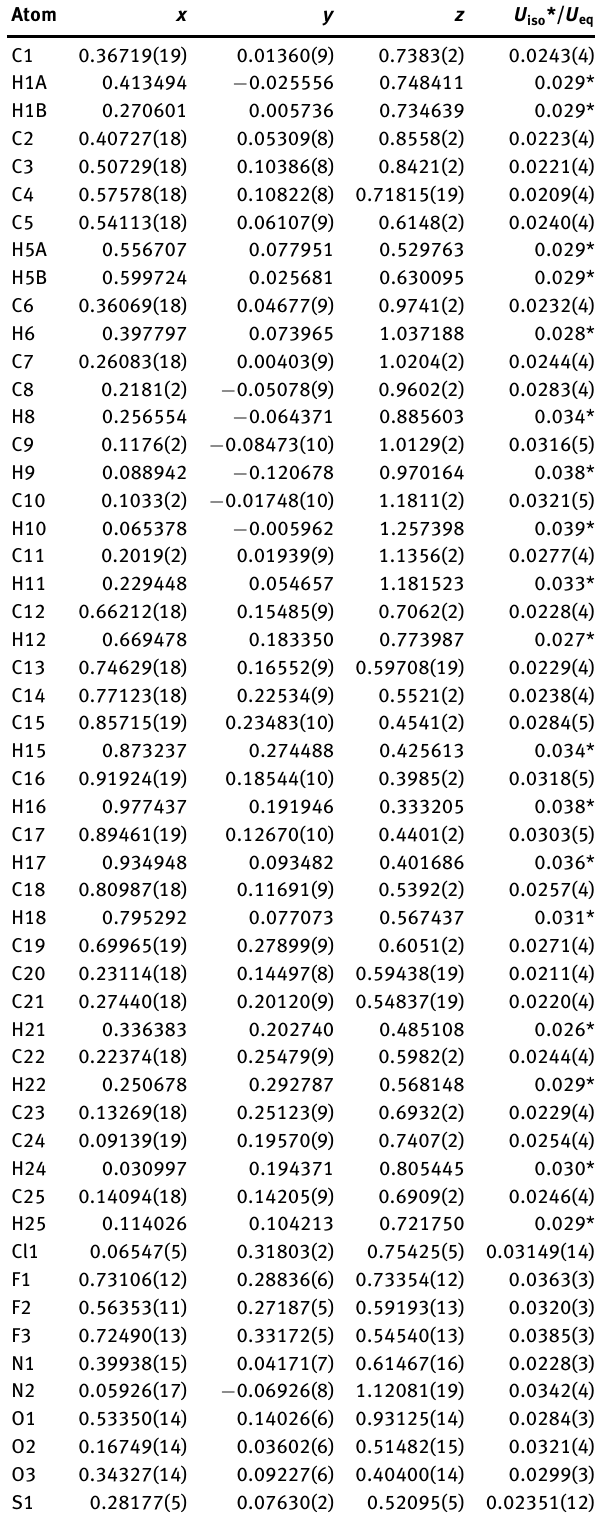
Table 2: Fractional atomic coordinates and isotropic or equivalent isotropic displacement parameters (Å 2